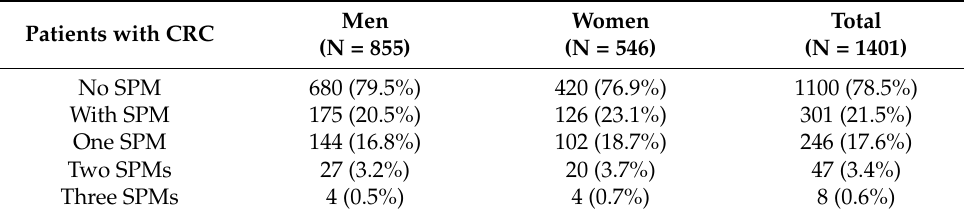
Table 2. Second primary malignancy in patients with colorectal cancer (C18–C20). Patients with CRC